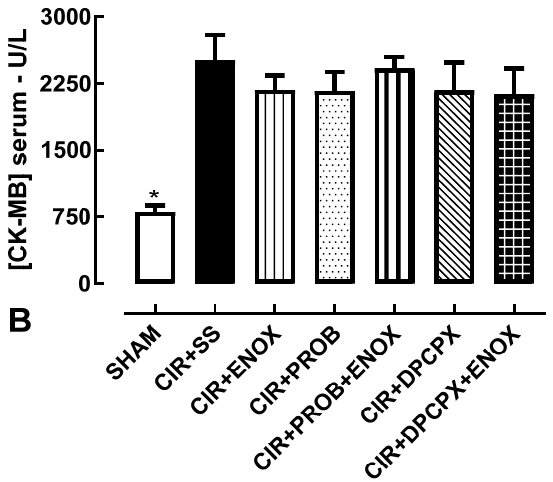
Figure 3. Serum concentration of CPK ( A ), and CK-MB ( B ) in the CIR + SS, CIR + ENOX, CIR + PROB, CIR + PROB + ENOX, and CIR + DPCPX + ENOX groups. The results are expressed as mean ± standard deviation of the mean, and analysis of variance (ANOVA) was applied, followed by the Tukey post-test (* p < 0.05). Serum levels of biochemical markers of cardiac injury in the SHAM group were lower than in the other groups, both CPK and CK-MB. CIR + SS = cardiac ischemia and reperfusion group treated with saline solution; CIR + ENOX = cardiac ischemia and reperfusion group treated with enoxaparin; CIR + PROB = cardiac ischemia and reperfusion group treated with probenecid 5 min before induction of CIR; CIR + PROB + ENOX = cardiac ischemia and reperfusion group treated with probenecid 5 min before treatment with enoxaparin, administered immediately before induction of CIR; CIR + DPCPX + ENOX = cardiac ischemia and reperfusion group treated with DPCPX 5 min before treatment with enoxaparin, administered immediately before induction of